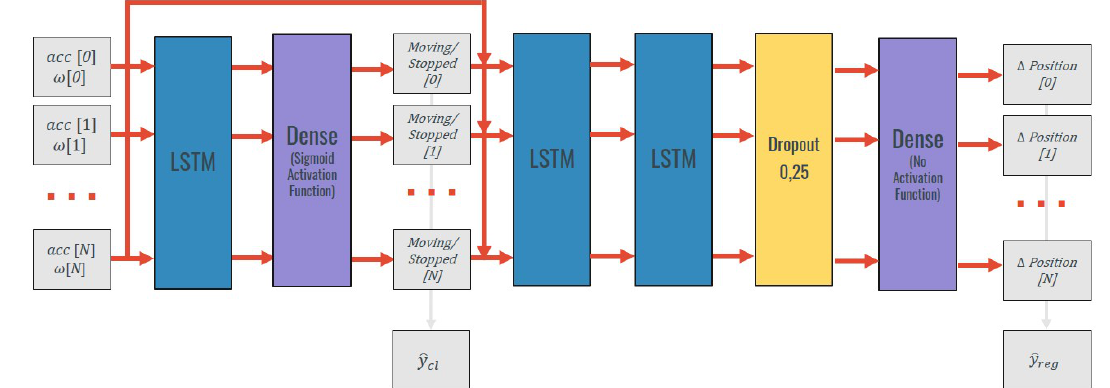
Figure 7. Stacked neural network for simultaneous classification and